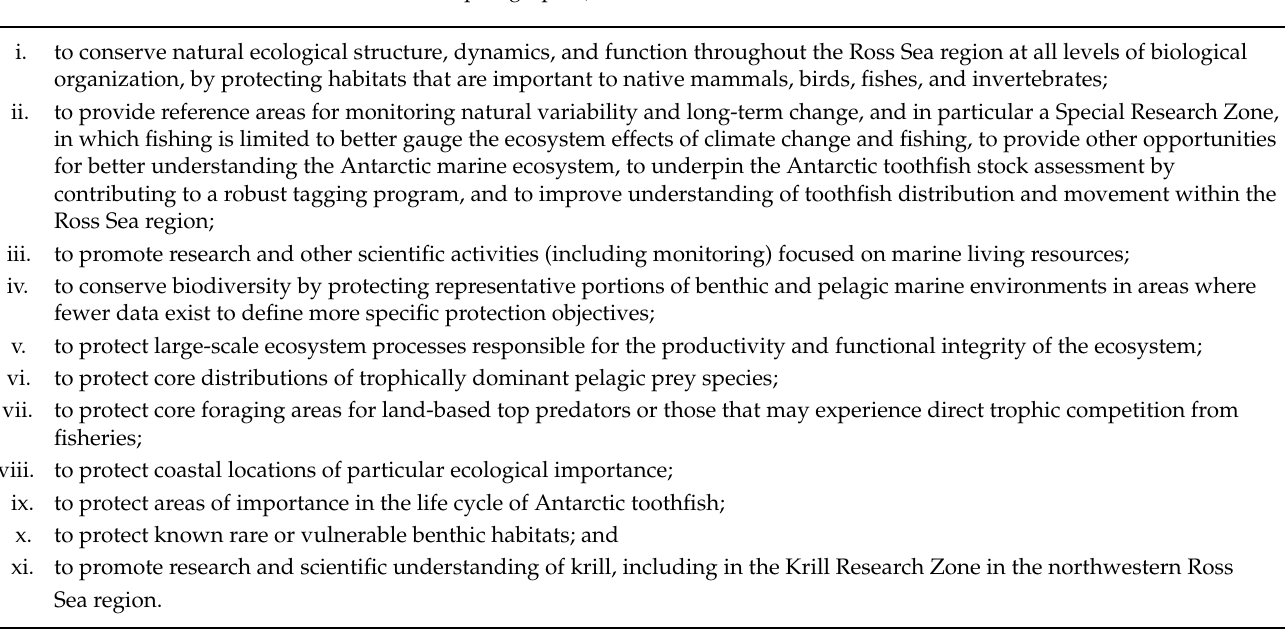
Table 1. Objectives of the Ross Sea region marine protected area (from CCAMLR Conservation Measure 91-05, paragraph